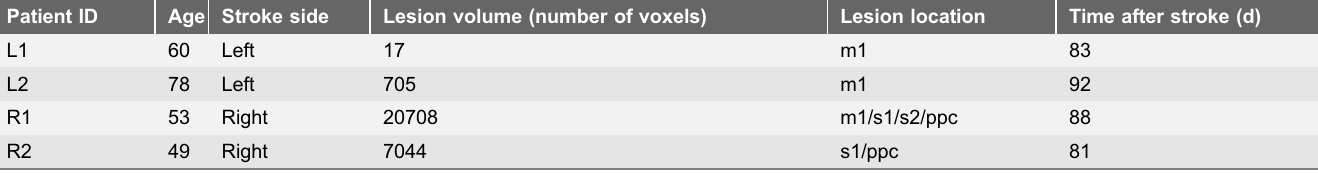
Table 1. Demographic characteristics of the stroke patients included in our additional